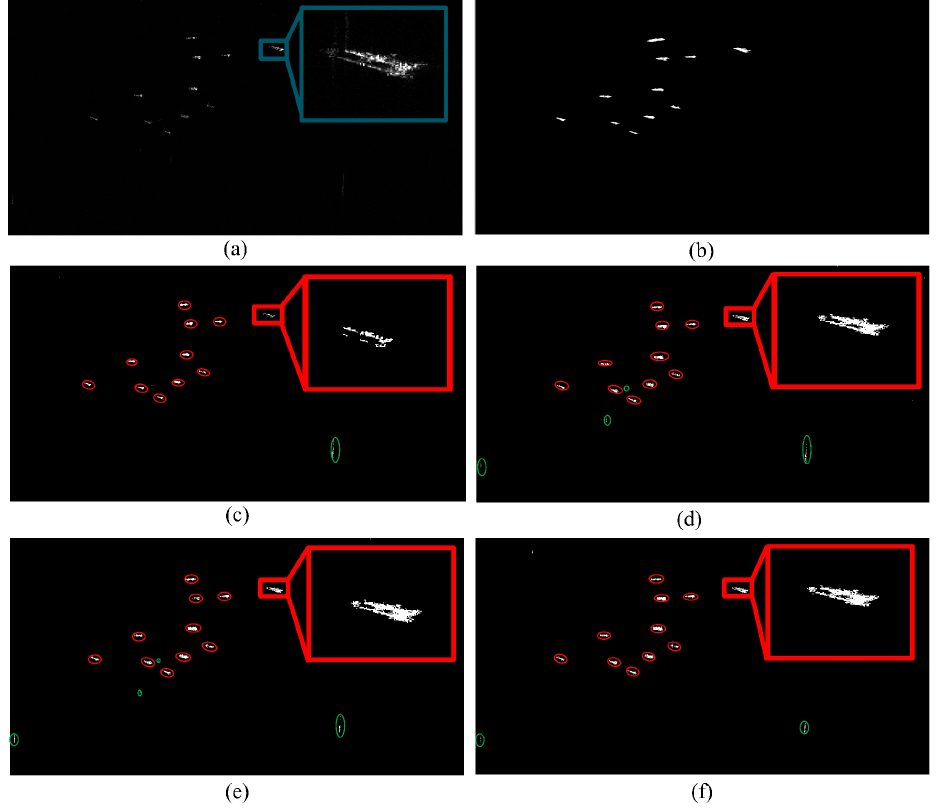
Figure 9. The detection results. p fa = 10 − 6 ( a ) Two-parameter method. ( b ) Multiscale method. ( c ) Superpixel method. The red ellipses and green ellipses in the figures represent the correct and false test results respectively.